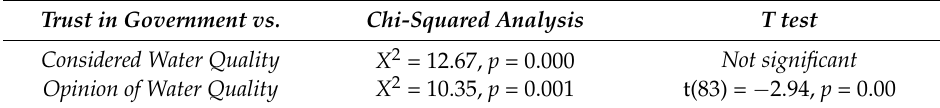
Table 3. Relationships relevant to trust in government.